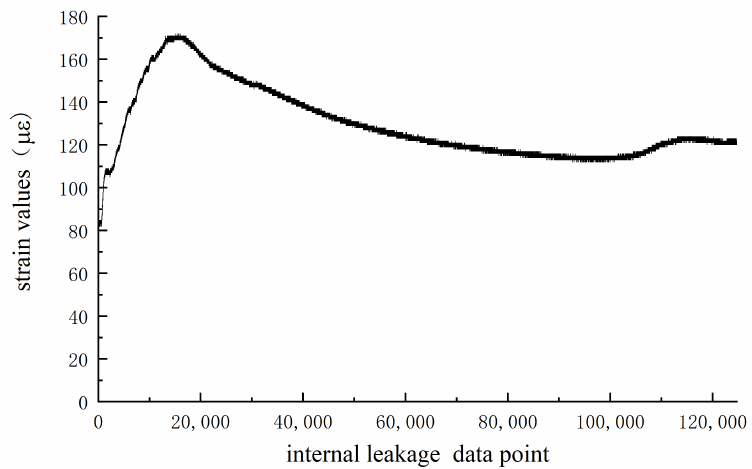
Figure 6. Strain